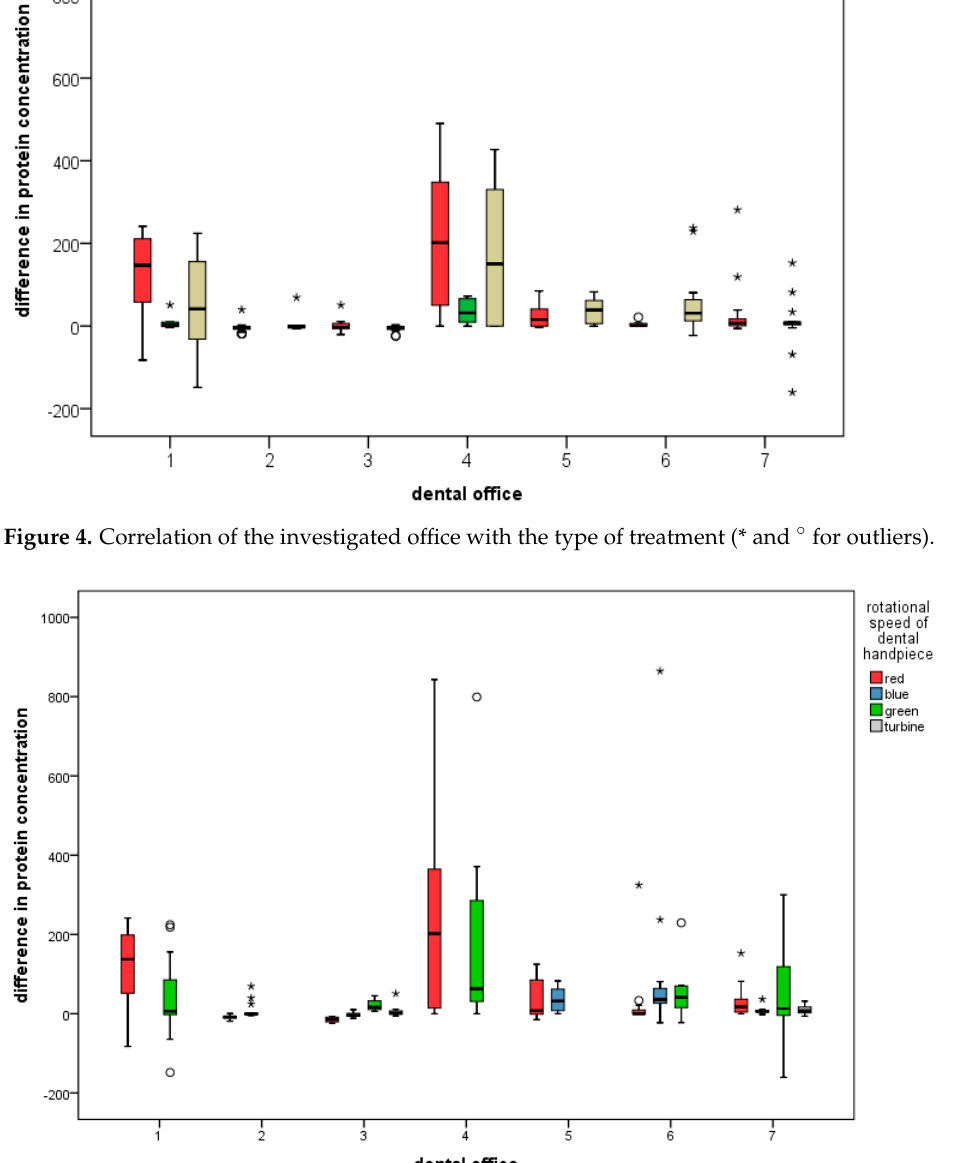
Figure 5. Correlation of office with the type of handpiece used (* and ° for outliers).